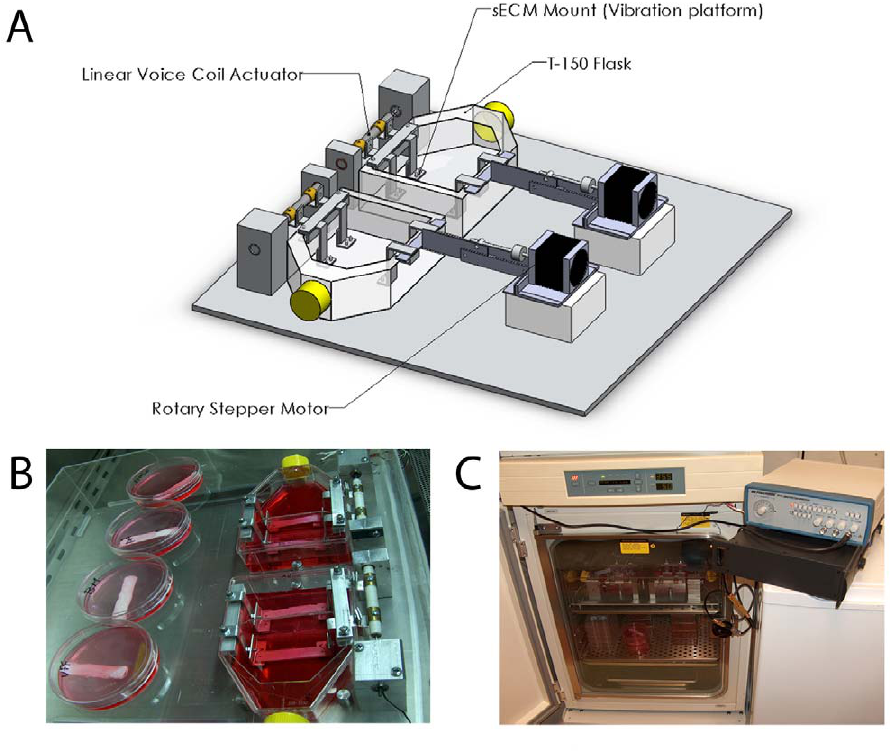
Figure 1. Schematic of the developed bioreactor. A. Bioreactor including T-flask, substrate, voice-coil actuator, linear stepper motors, rotary stepper motors, and scissor bars. B. Experimental setup, with static attachment in place of stepper motors. Non-vibrated controls can also be seen. C. Bioreactor within incubator. Wave-form generator is next to the incubator, sitting on top of the power amplifier.